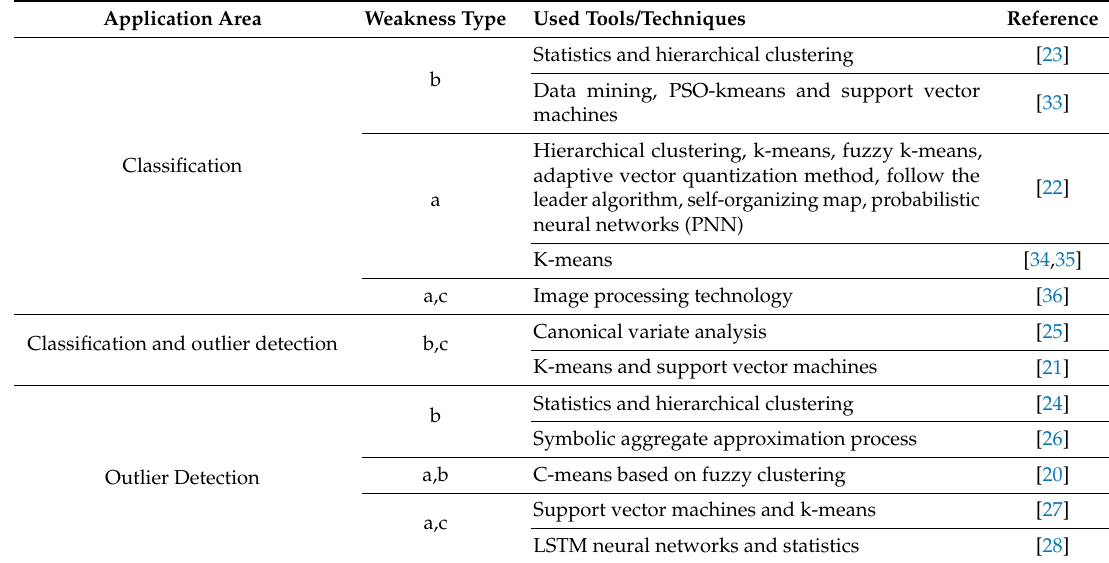
Table 2. Literature review on electricity